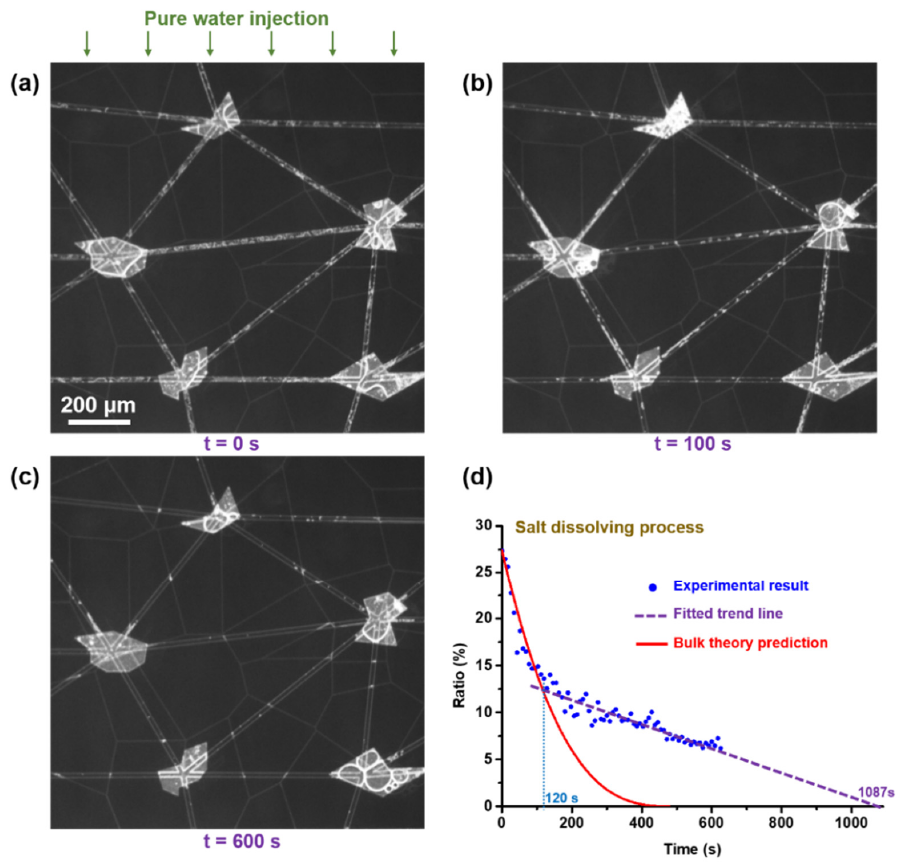
Figure 7. Salt dissolution dynamics in the 500-nm deep network. ( a – c ) are recorded images of salt dissolution at 0, 100 and 600 s. ( d ) Experimental results of the salt dissolution process, classical bulk dissolution theory prediction and fitted trend line based on experimental results.